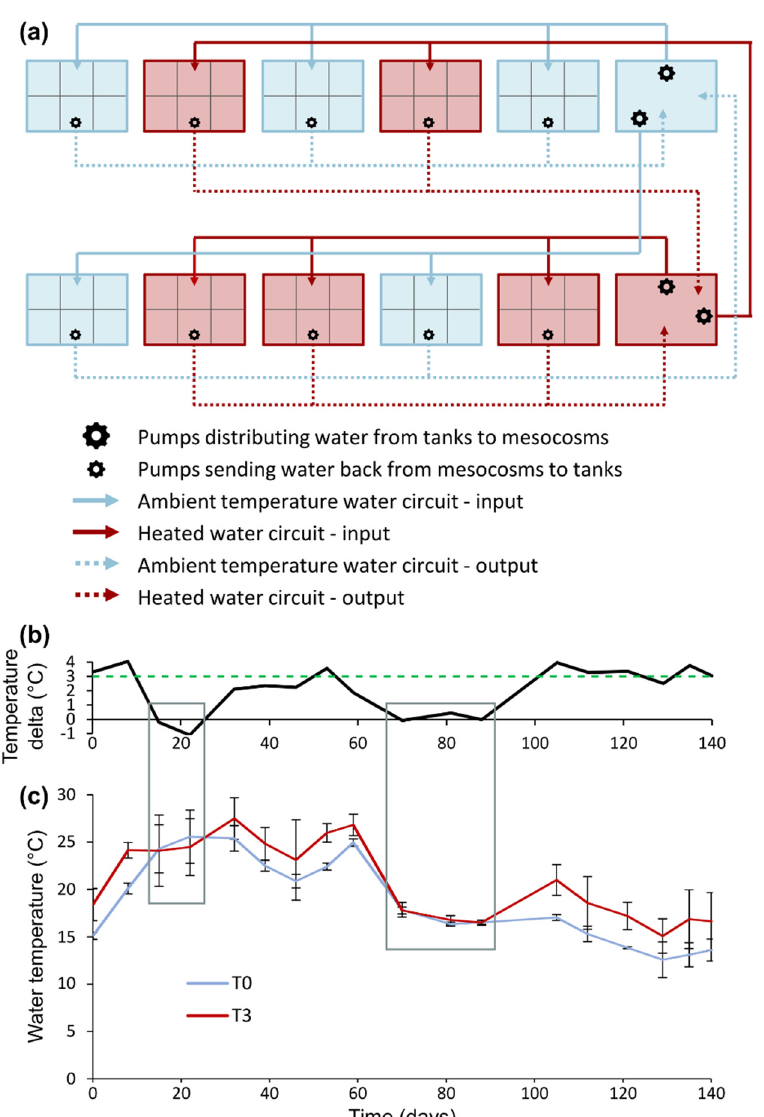
Figure 6. ( a ) Experimental design and water circulation between mesocosms and tanks. ( b ) Mean temperature delta between heated water mesocosms and ambient temperature mesocosms. The green dashed line represents the 3 °C warming objective. ( c ) Mean water temperature (± standard deviation) in heated mesocosms (T3) and ambient temperature mesocosms (T0) during the duration of the experiment. Grey frames highlight two periods when the experimental warming was off due to technical issues.